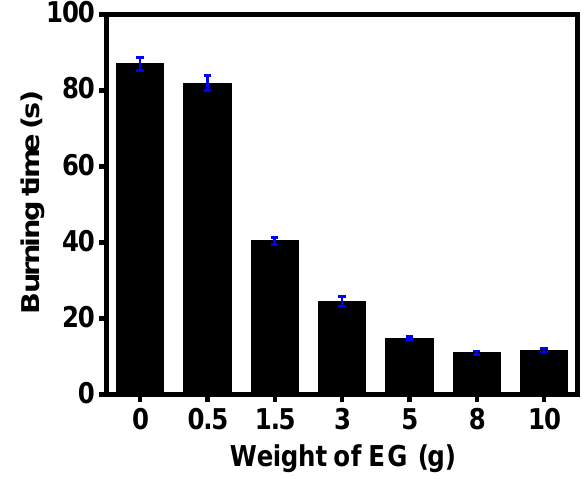
Figure 10. Burning time for the carvone-based PU foams with an increasing amount of EG.